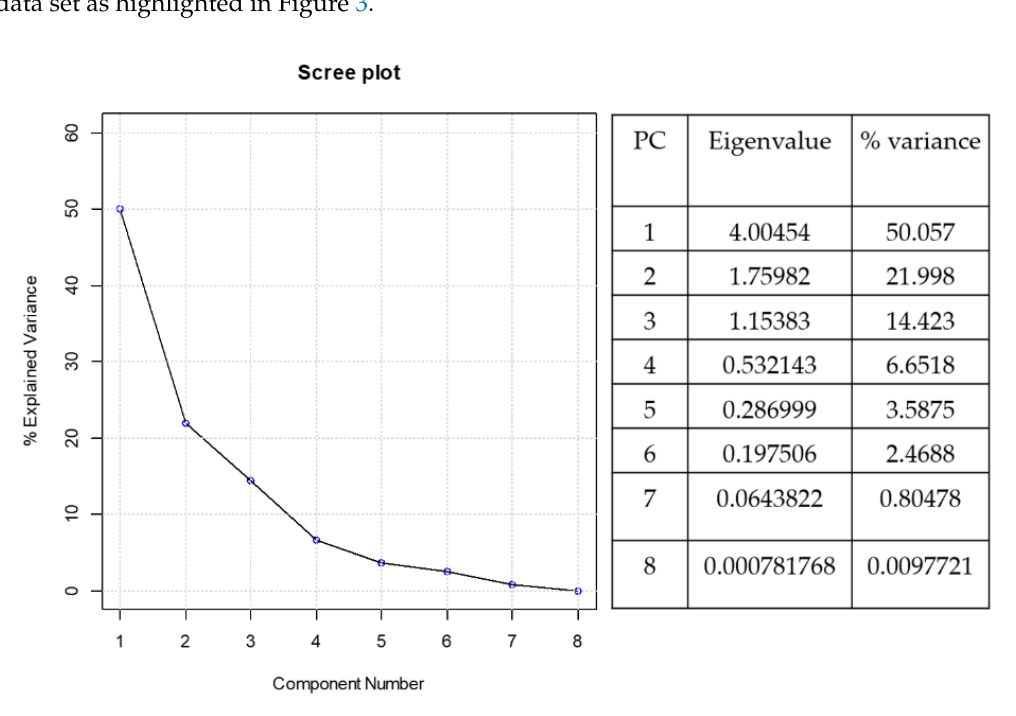
Figure 3. Scree plot: % explained variance of each PCs.